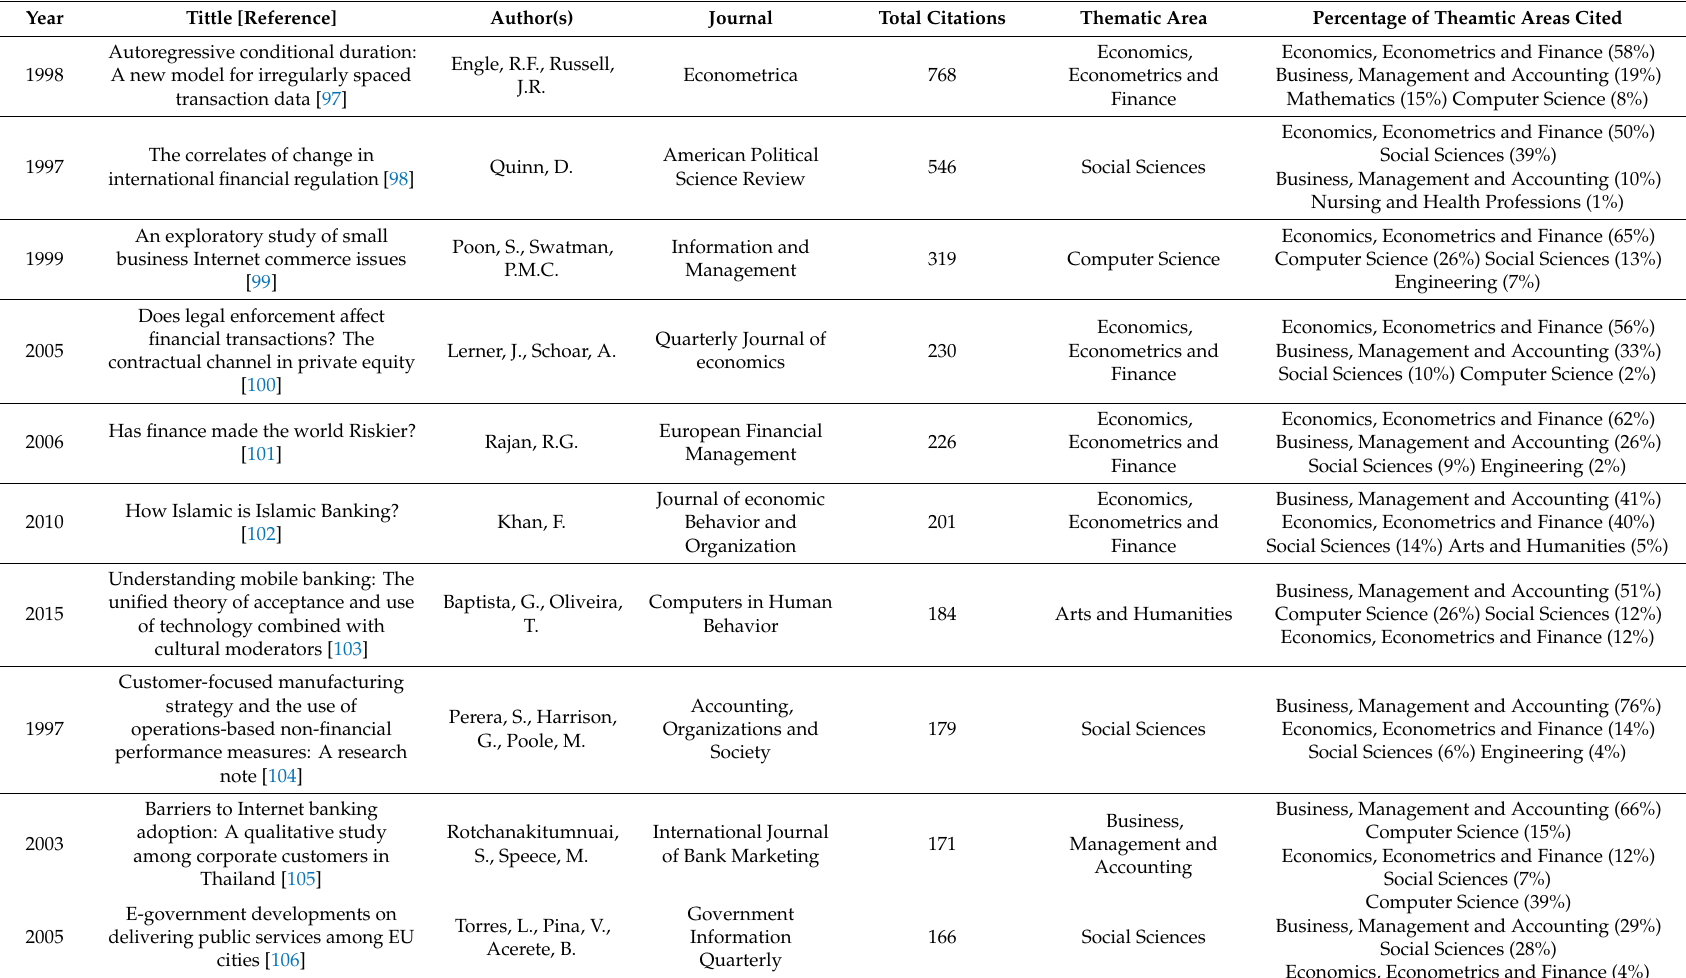
Table 2. Most cited articles and their significant impacts on the research of financial transactions